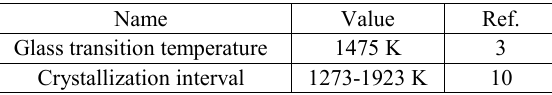
Table 2. Temperatures of glass transition and